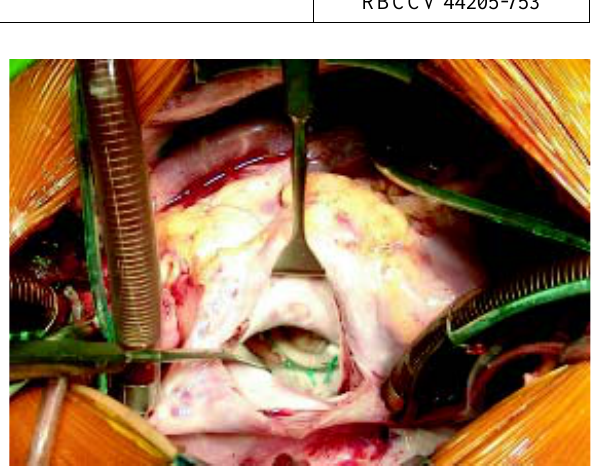
Fig. 1- Anel de Gregori utilizado na plastia da valva mitral visibilizado através de abertura longitudinal no septo interatrial